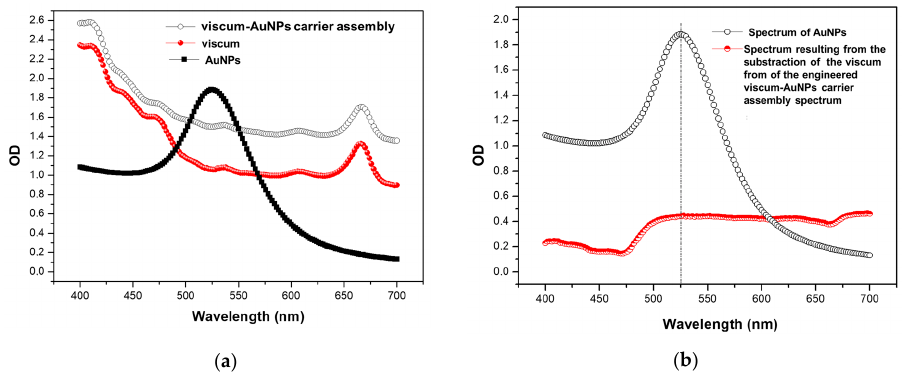
Figure 10. ( a ) UV–Vis spectra of the AuNPs, viscum, and engineered viscum–AuNPs carrier assembly respectively. ( b ) UV–Vis spectrum resulting from subtracting the UV–VIS spectra of the AuNPs from the UV–Vis spectrum of the engineered viscum–AuNPs carrier assembly.